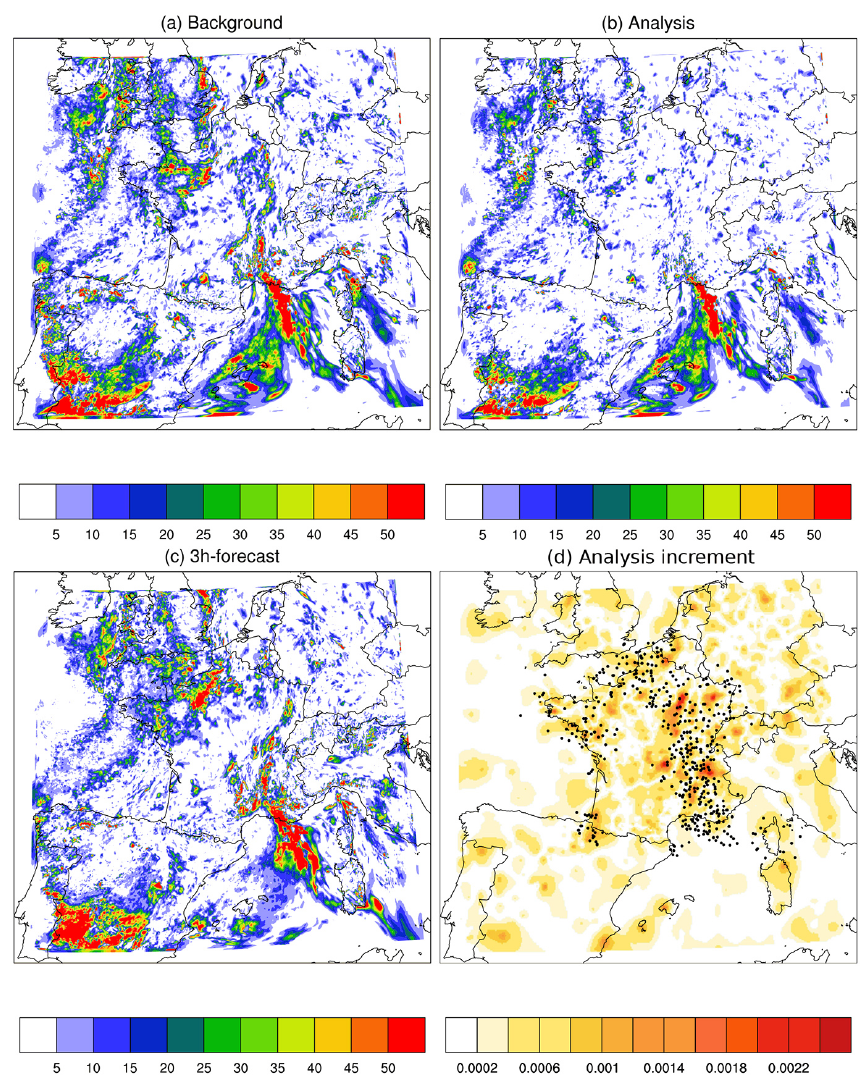
Figure 8. K 2 for q at level 52 ( ≈ 920hPa) for (a) the background, (b) the analysis, and (c) the following 3h forecast starting at 03:00UTC on 4 November 2011. (d) Corresponding analysis increment (kgkg − 1 ) with positions of radar precipitation observations